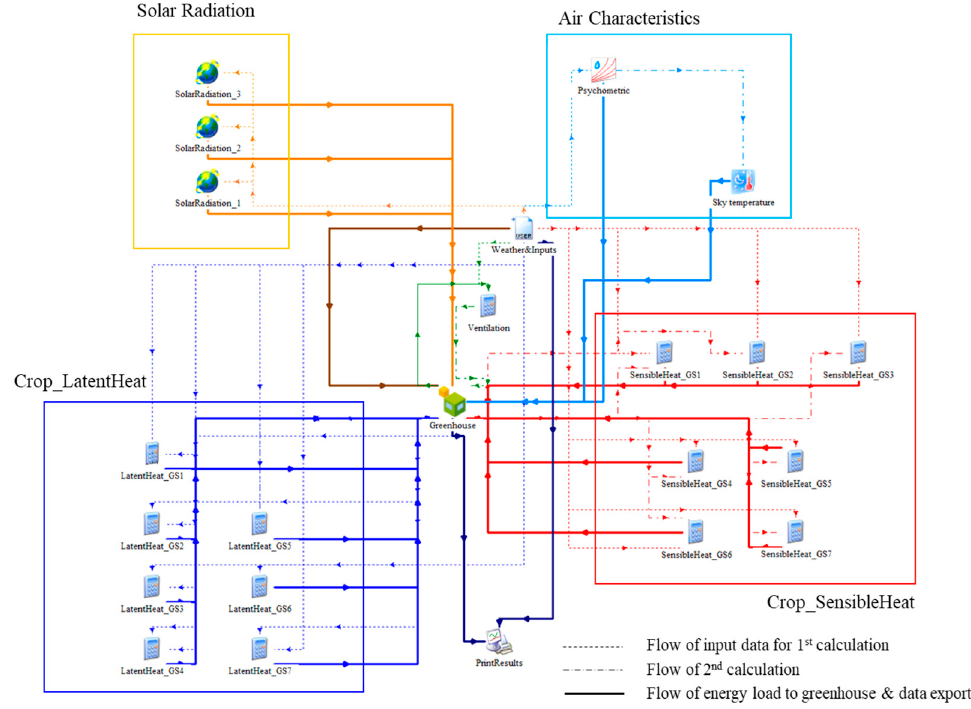
Figure 12. Module configuration of greenhouse BES model to consider tomato model (sensible and latent heat) by growth stage. latent heat) by growth